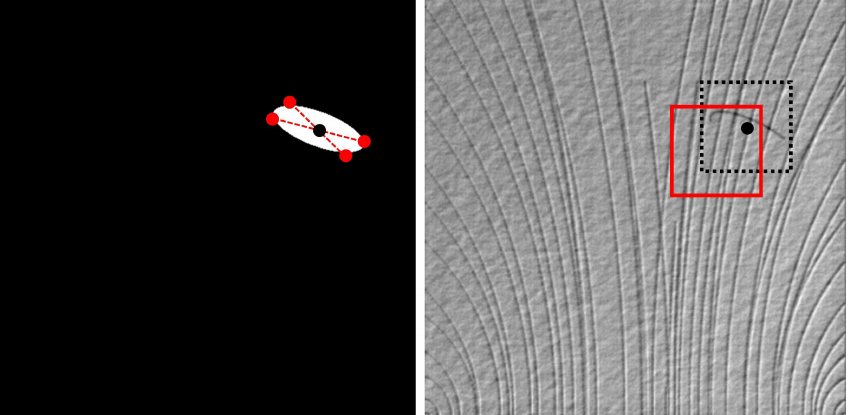
Figure 7. Label image ( left ) and defect image ( right ) in DAGM. The black spot is the center of the defect, the red rectangle is the defect patch we extracted after offset.